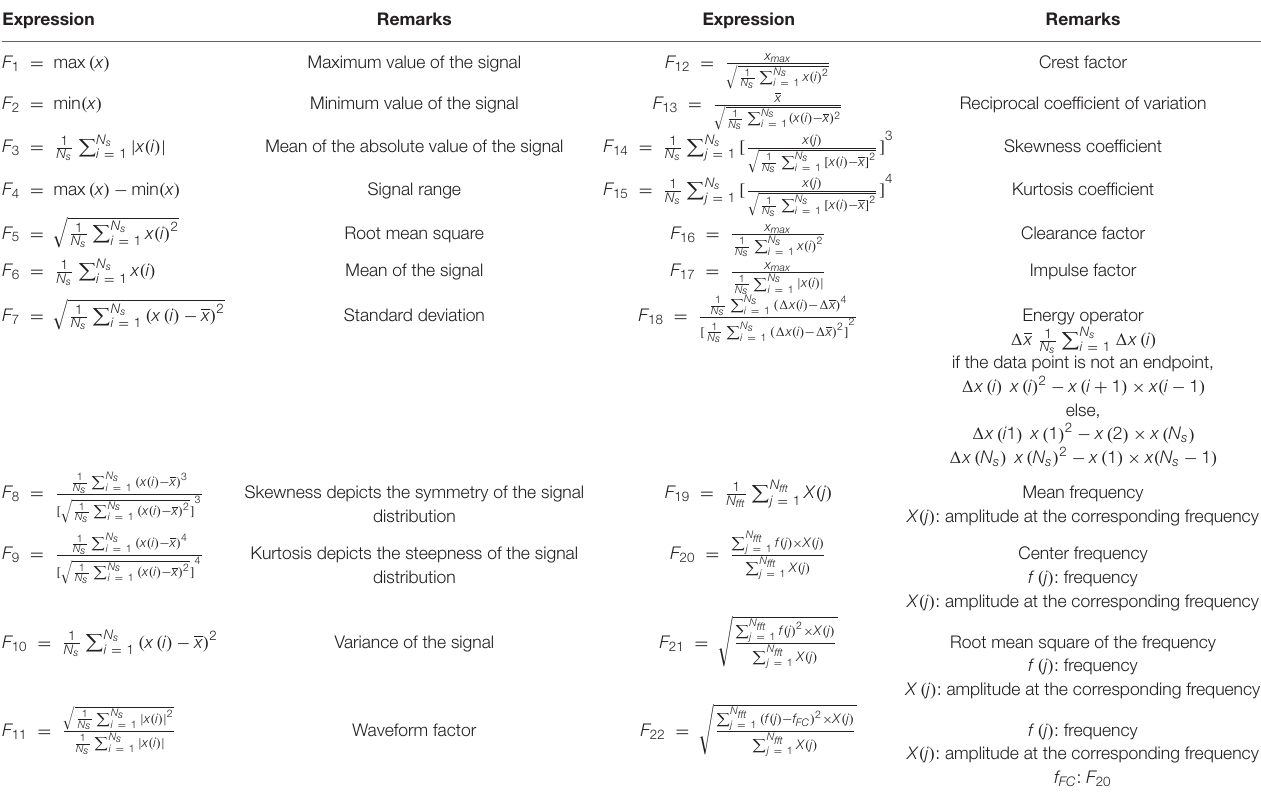
TABLE 2 | Information on the features extracted from the signal. Expression